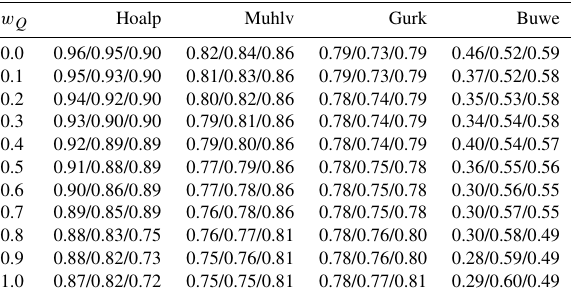
Table 3. Runoff model efficiency Z Q (Eq. 2) obtained for differ- ent weights w Q in the four catchments for three calibration periods. w Q = 0 and w Q = 1 emphasise low flows and high flow, respec- tively, in the calibration. Z Q are listed in the sequence of the cali- bration periods: